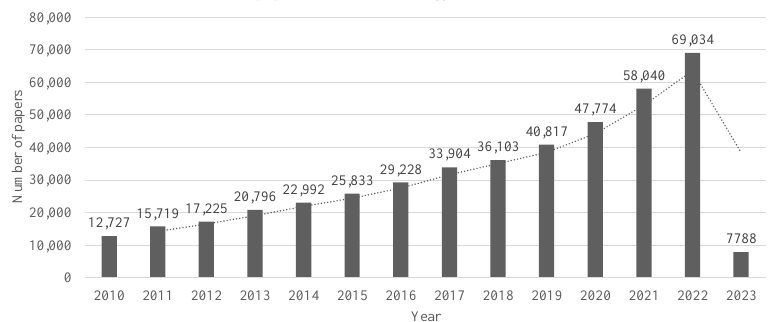
Figure 10. Development of research in waste to energy (2010–2022). The dotted line represents the moving average of the published